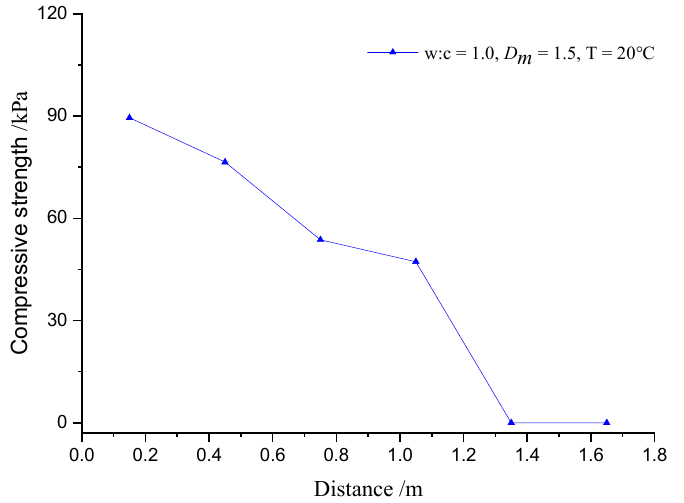
Figure 3. Variation pattern of uniaxial compressive strength versus distance for each test point (the water–cement ratio is 1.0; the fractal dimension of pores is 1.5; temperature is 20 °C).